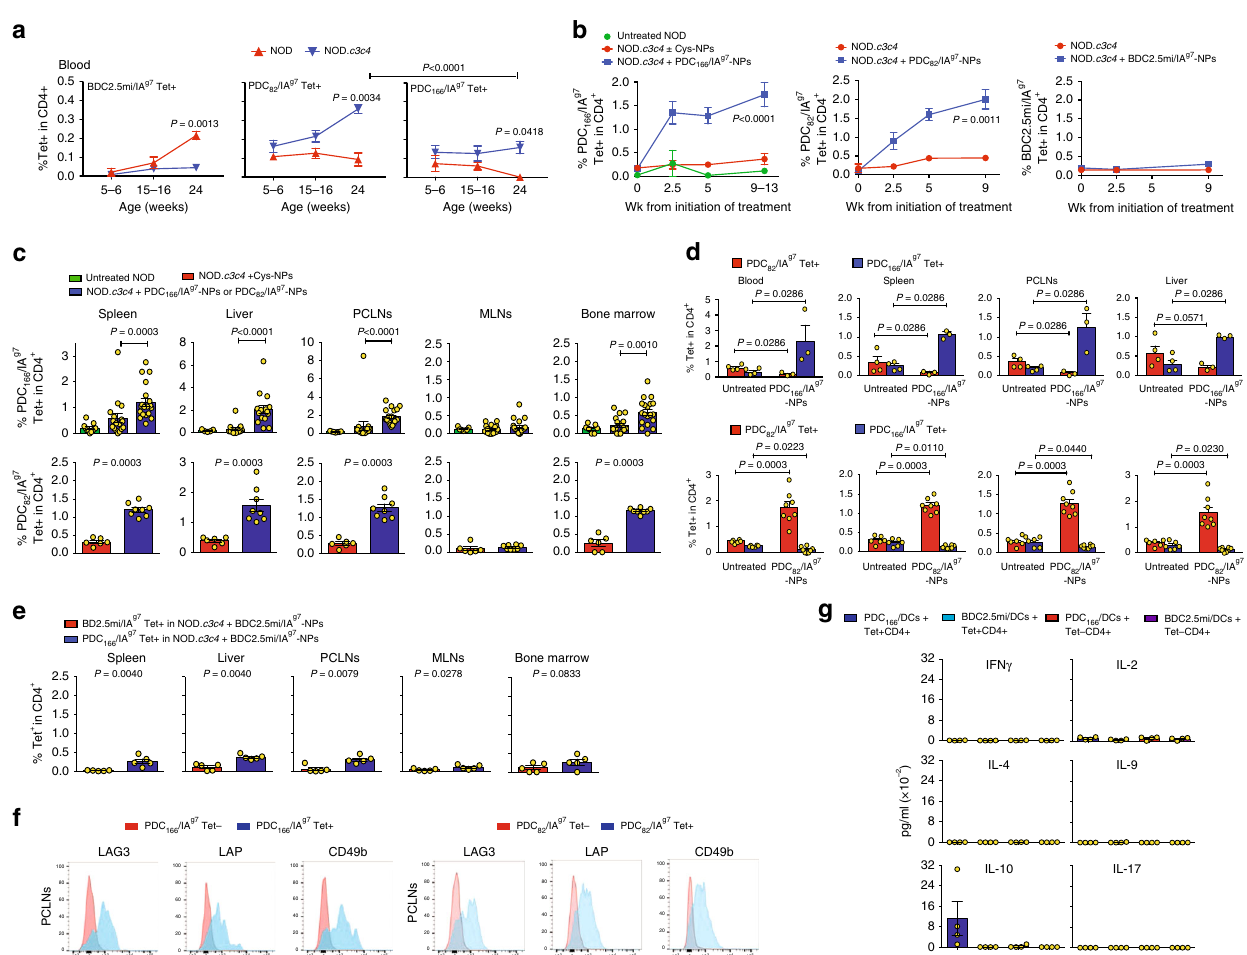
Fig. 1 Mitochondrial autoantigen-based pMHCII-NPs expand cognate TR1 cells. a Percentages of tetramer + CD4 + cells in blood of NOD vs. NOD.